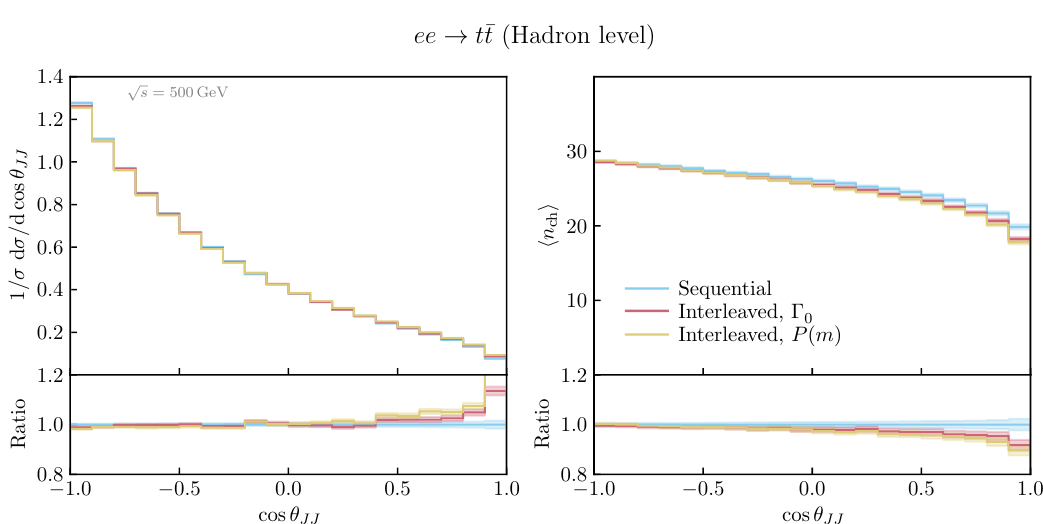
Figure 7: Distributions of the angle between the two clustered jets (left), and the average charged multiplicity as a function of that angle (right), in leptonic e + e − → t ¯ t (cid:112) s = events at